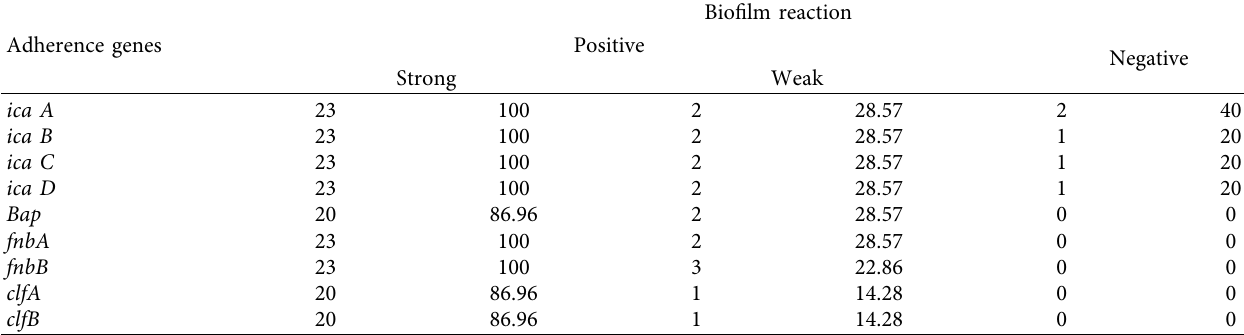
Table 8: Adherence of attachment factors in S. aureus strains isolated from row cow milk based on biofilm reaction. Adherence